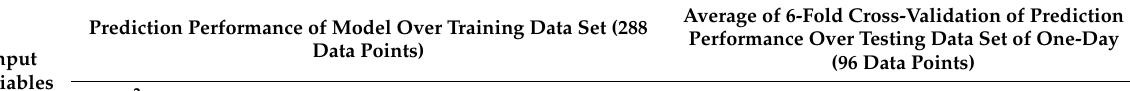
Table 4. Prediction performance of SVR model of T ma over training data set of three days and average testing results over the next six